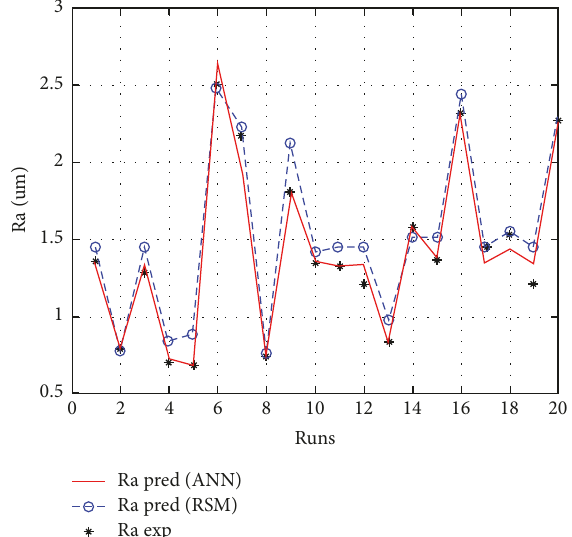
Figure 7: Experimental, RSM, and ANN predicted results for Ra .